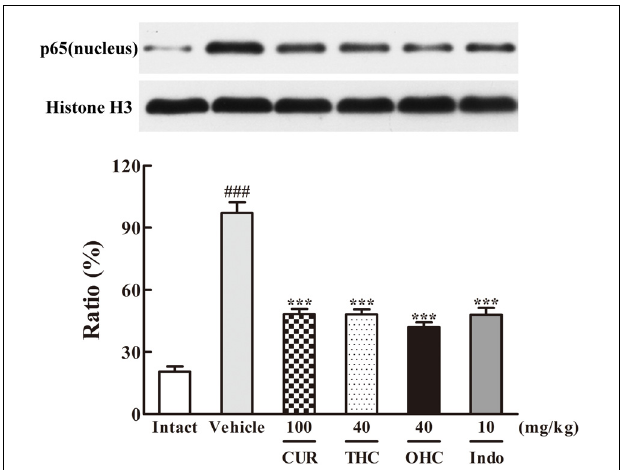
FIGURE 8 | Effects of THC and OHC on p65 (nucleus) protein expression in the carrageenan-induced mouse paw edema. After administration with THC (40 mg/kg, i.g.), OHC (40 mg/kg, i.g.) or CUR (100 mg/kg, i.g.) for 7 days, the hind paws were removed and homogenized in the lysis buffer, and then the protein extracts of hind paws were transferred to PVDF membranes and analyzed by Western blot. Histone H3 was employed as loading control. Data were expressed as means ± S.E.M. ( n = 3), ### p < 0.001 vs. the intact control; ∗∗∗ p < 0.001 vs. the vehicle control. Significant differences between groups were determined by ANOVA and Dunnett’s post hoc